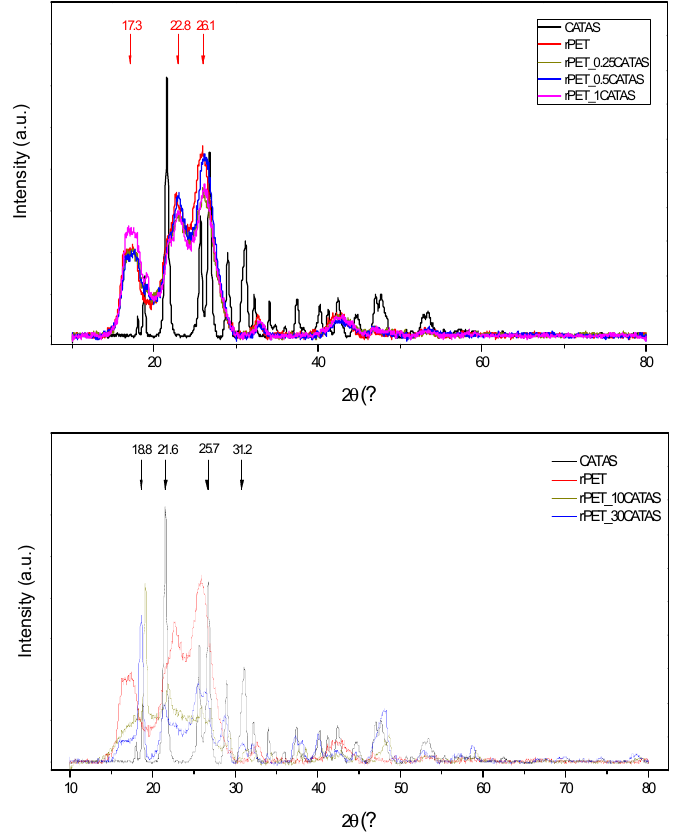
Figure 5. XRD diffraction curves for rPET and rPET/CATAS nanocomposites at low and high loadings. Figure 5. XRD di ff raction curves for rPET and rPET / CATAS nanocomposites at low and high